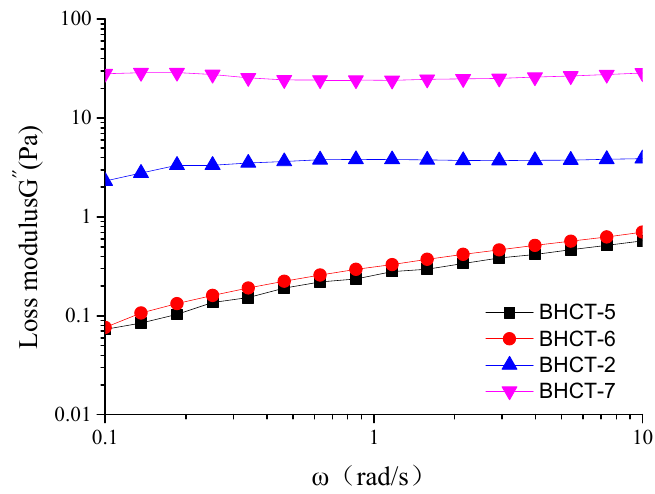
Figure 11. Elastic modulus of composite gels with different bentonite contents.